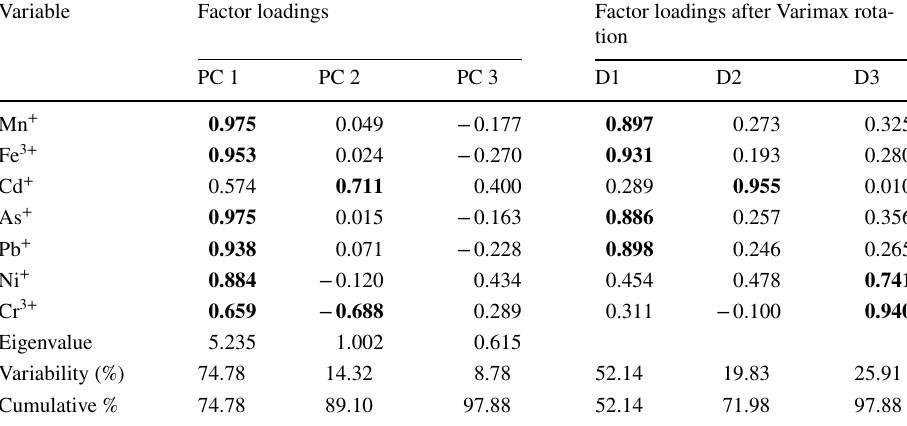
Values in bold correspond to each variable that contribute very strongly to the factors considered (Load- ing ≥